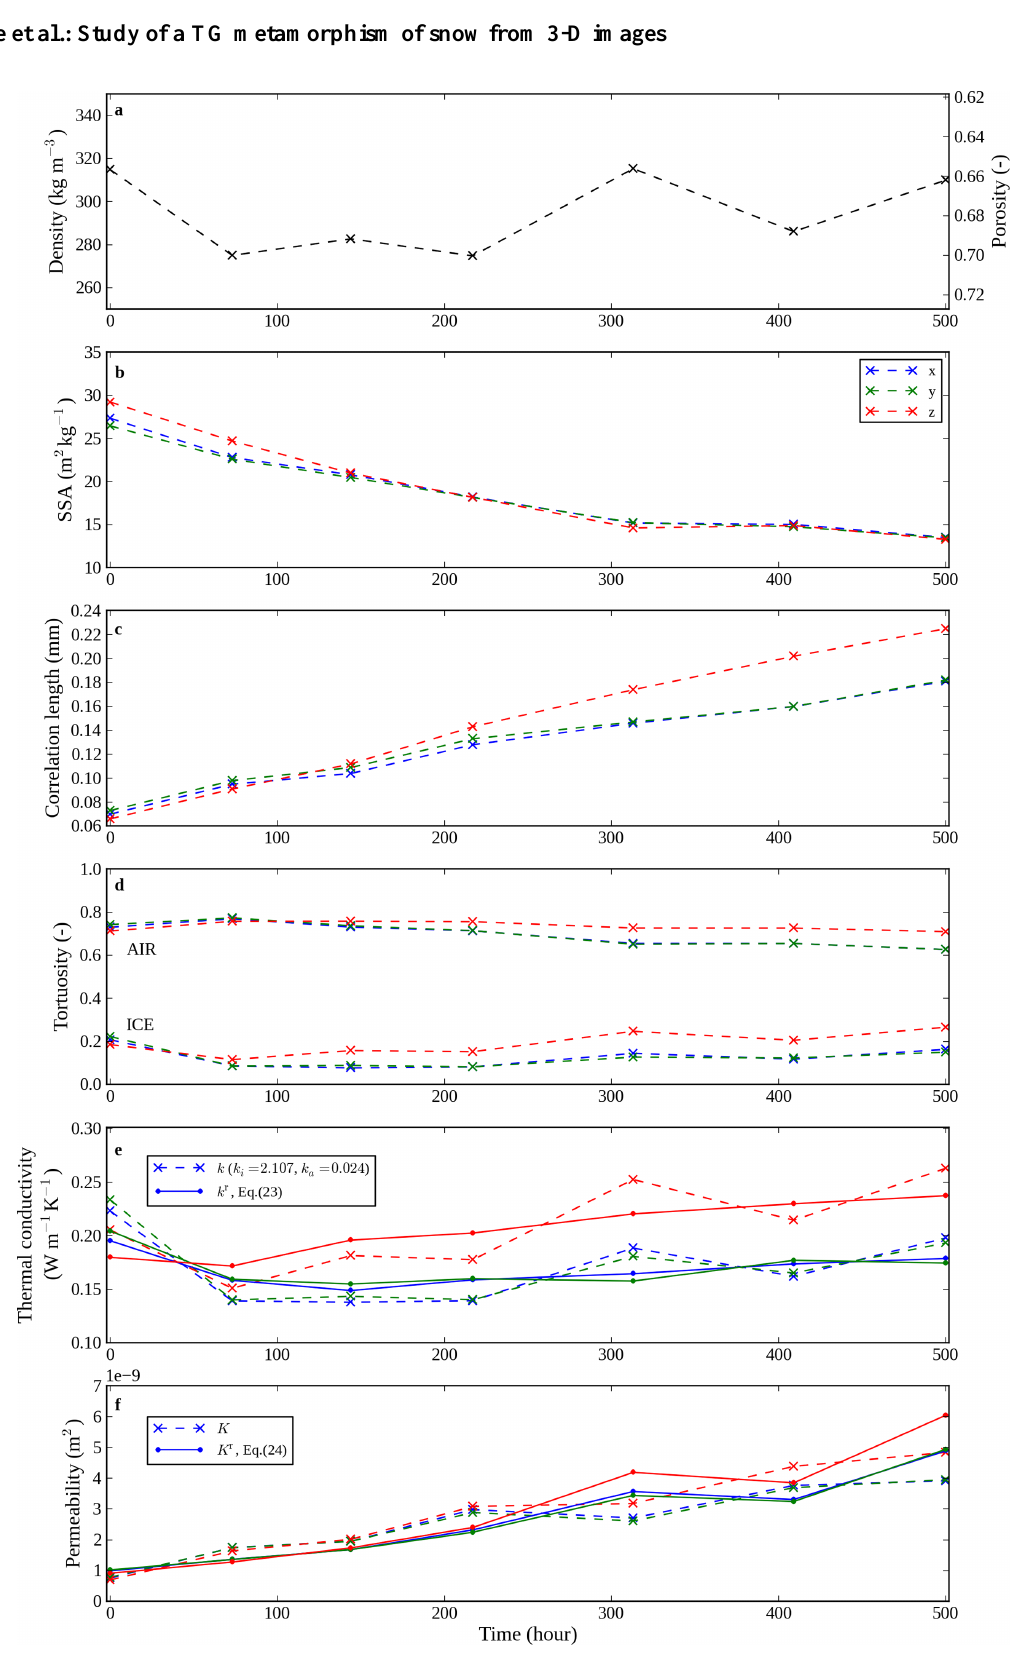
Figure 6. Time evolution of microstructural and physical properties of snow during the whole temperature gradient experiment. Values in the x , y and z directions are given in blue, green and red,